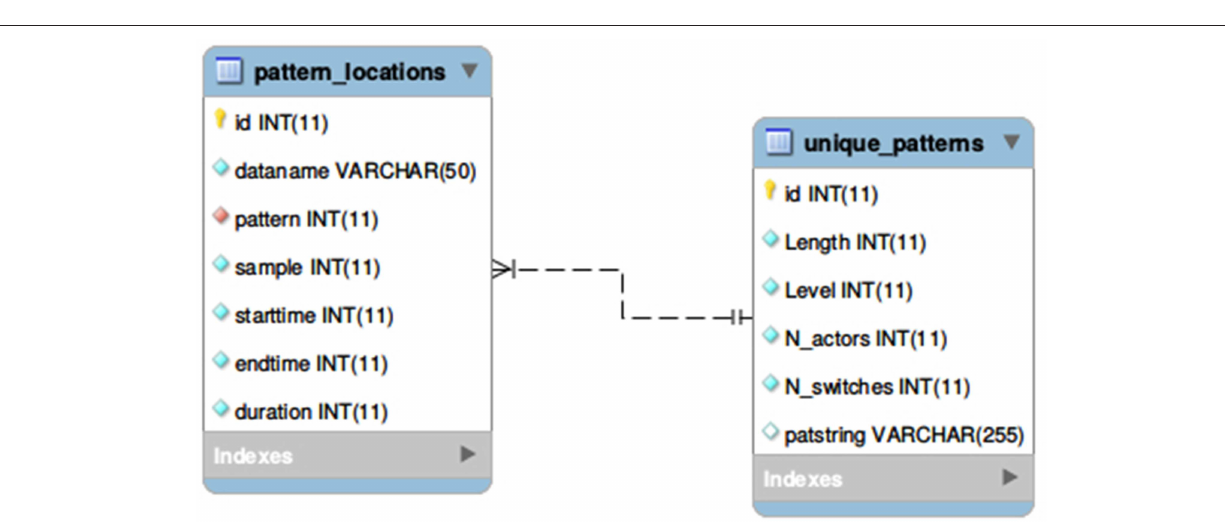
FIGURE 6 | Representing the result of T-pattern detection in a relational